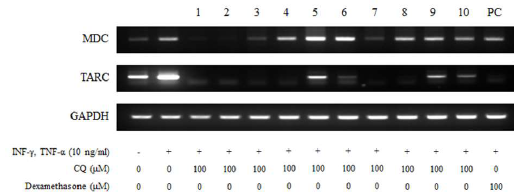
Figure A1. Effect of CQ on the expression of chemokines in HaCaT cells. HaCaT cells were treated